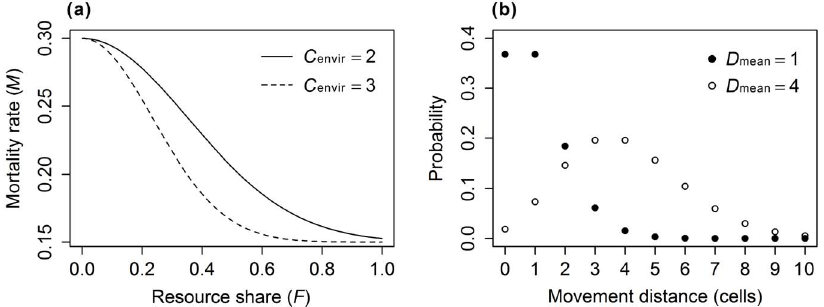
Figure 3. Movement distance distributions (a) and mortality rate functions (b) used to define hypothetical species in the model. C envir =2 and C envir =3 represent low-tolerant and high-tolerant species, respectively. D mean =1 and D mean =4 represent low-mobility and high- mobility species, respectively.